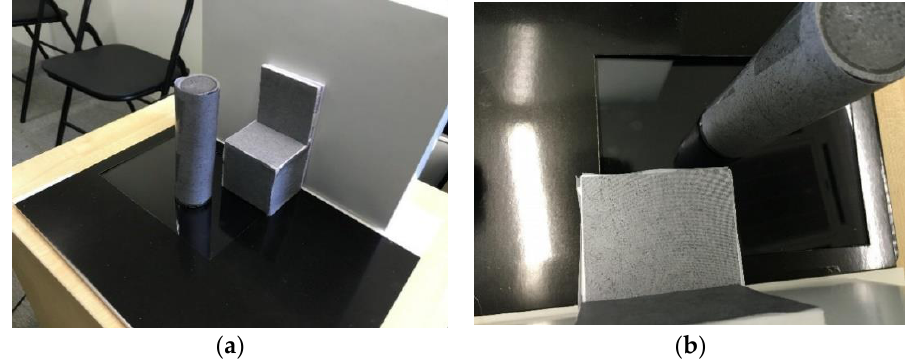
Figure 4. ( a ) The setup adopted to measure spatial perception. ( b ) A top view of the setup.